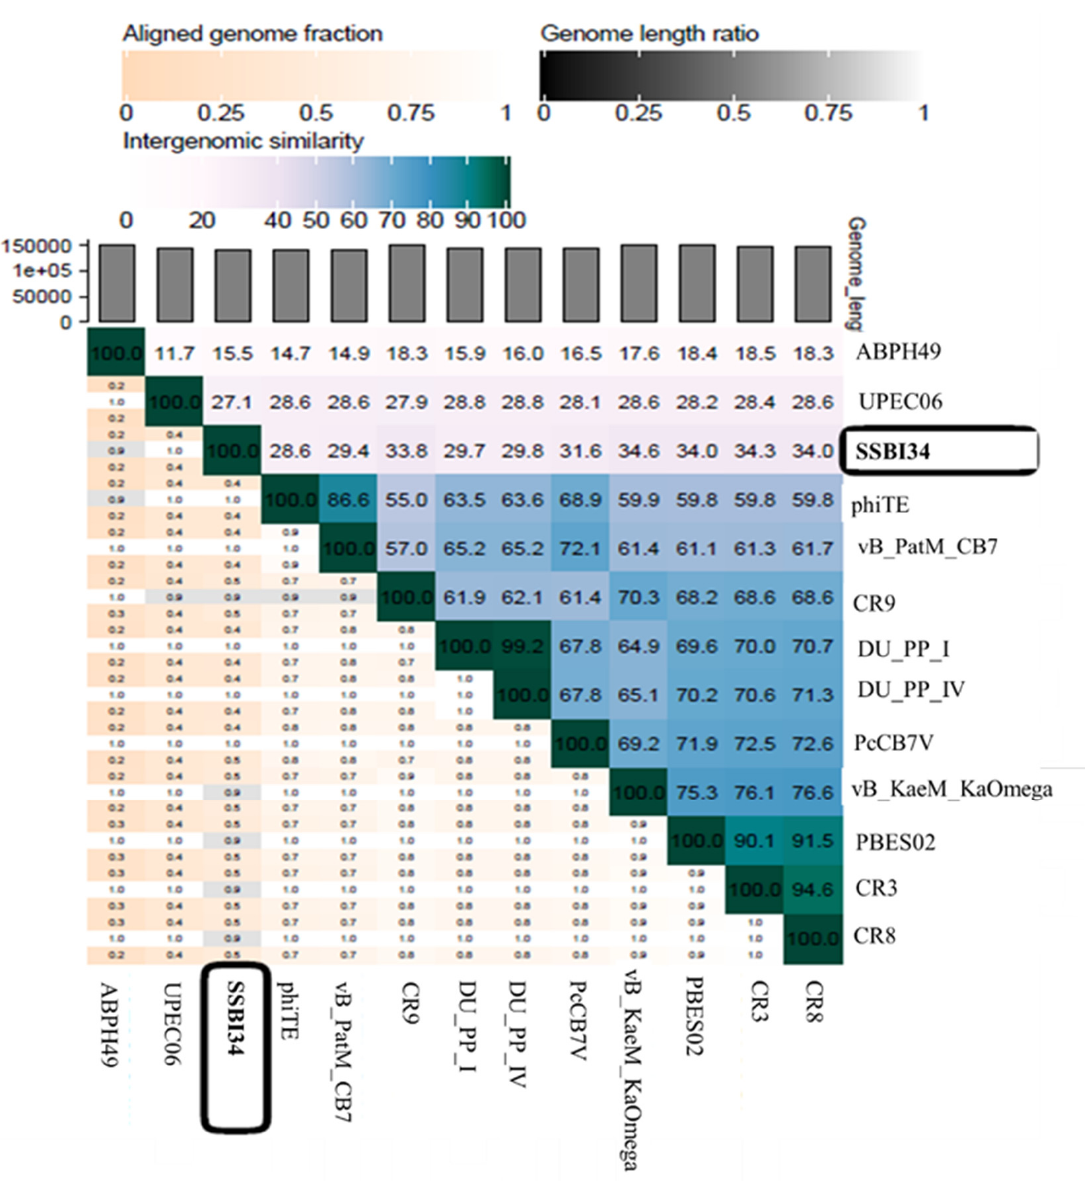
Figure 7. Heatmap generated after comparative genome analysis of Salmonella -phage-SSBI34 with its close homologs in BLASTn using VIRIDIC software.